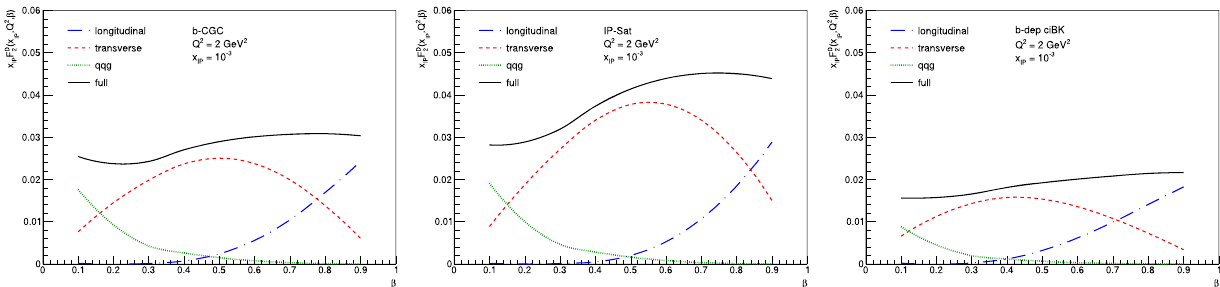
Fig. 6 Predictionsforthe β dependenceofthedifferentcomponentsof F D ( 3 )